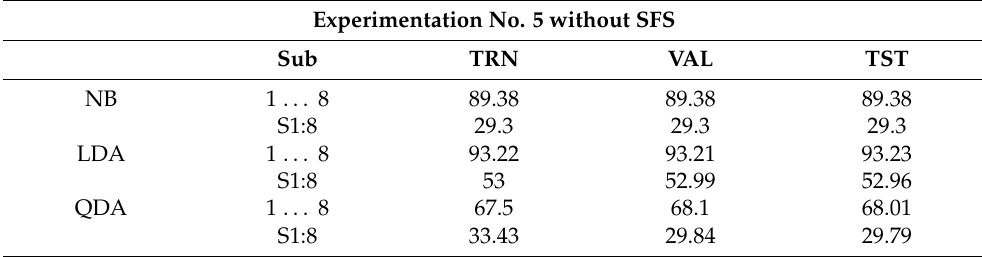
Table 5. Experimentation 5: Percentage of recognition using a 10 × 10 cross-validation by dividing the data into training (TRN), validation (VAL) and test (TST). The subject column is divided into two parts for each classifier; 1 . . . 8 indicates that an average was performed between the data of the eight subjects; S1:8 indicates that the total data were a single set of the eight individuals.